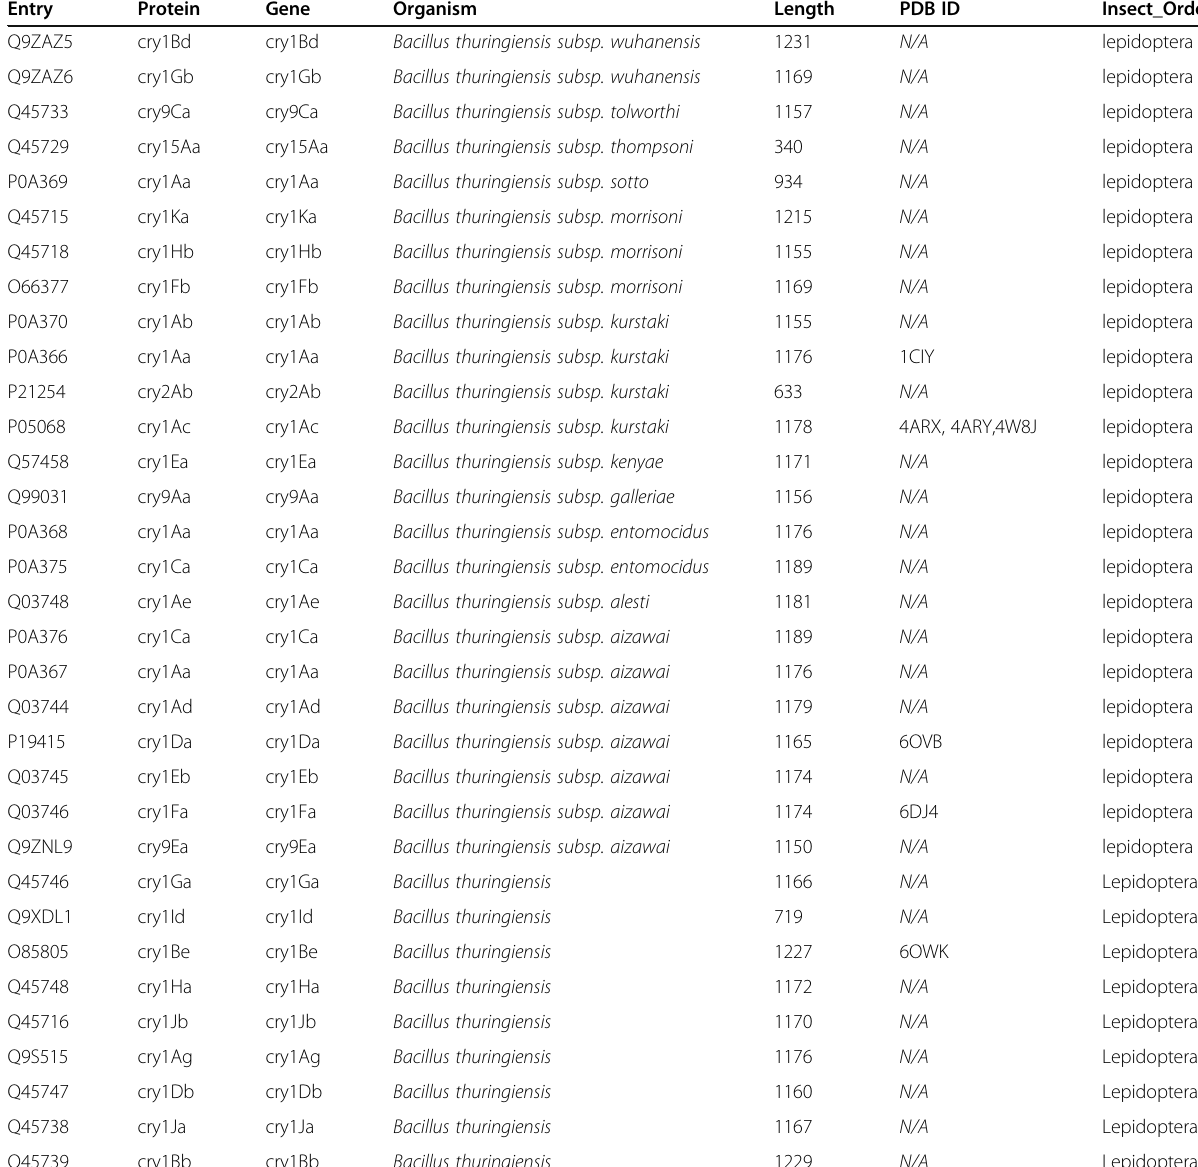
Table 3 List of cry proteins having toxicity for Lepidoptera insect